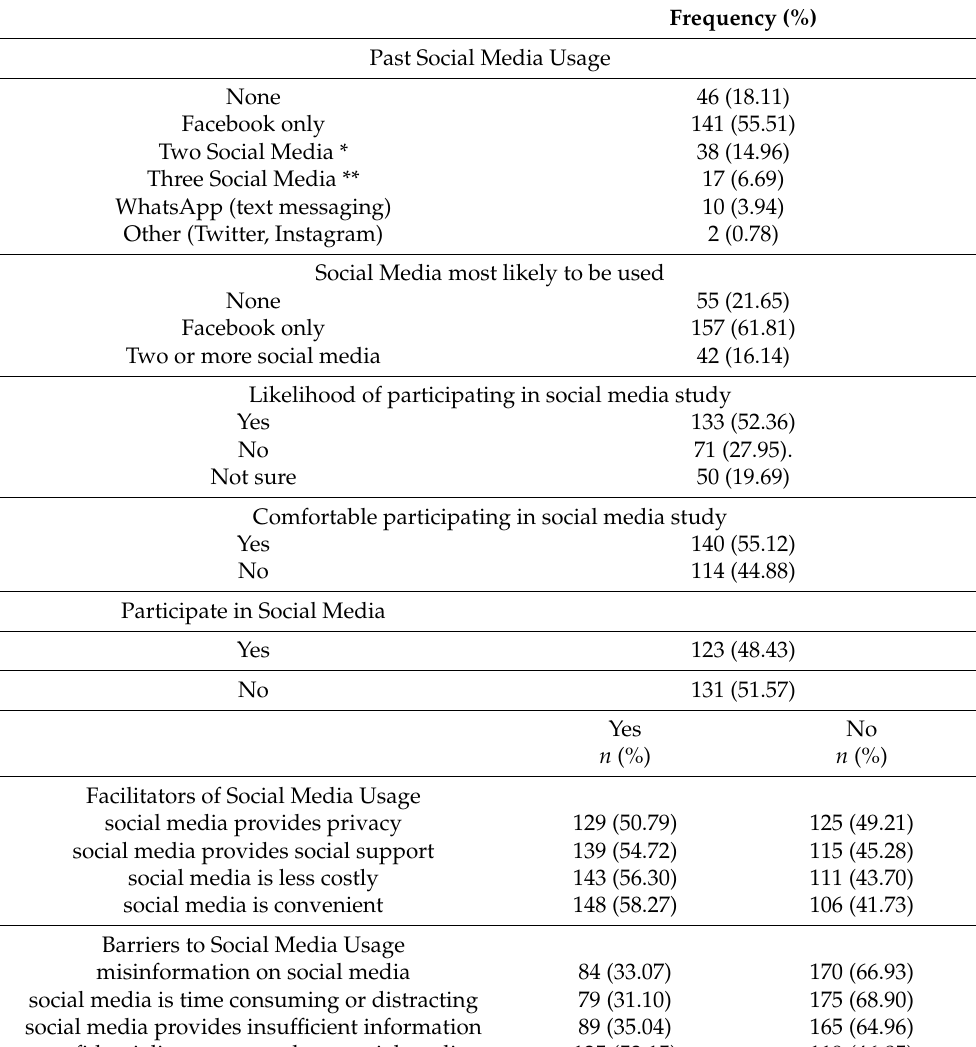
Table 3. Distribution of participants’ past social media usage behavior, likelihood to use social media, facilitators, and barriers to social media usage ( n =